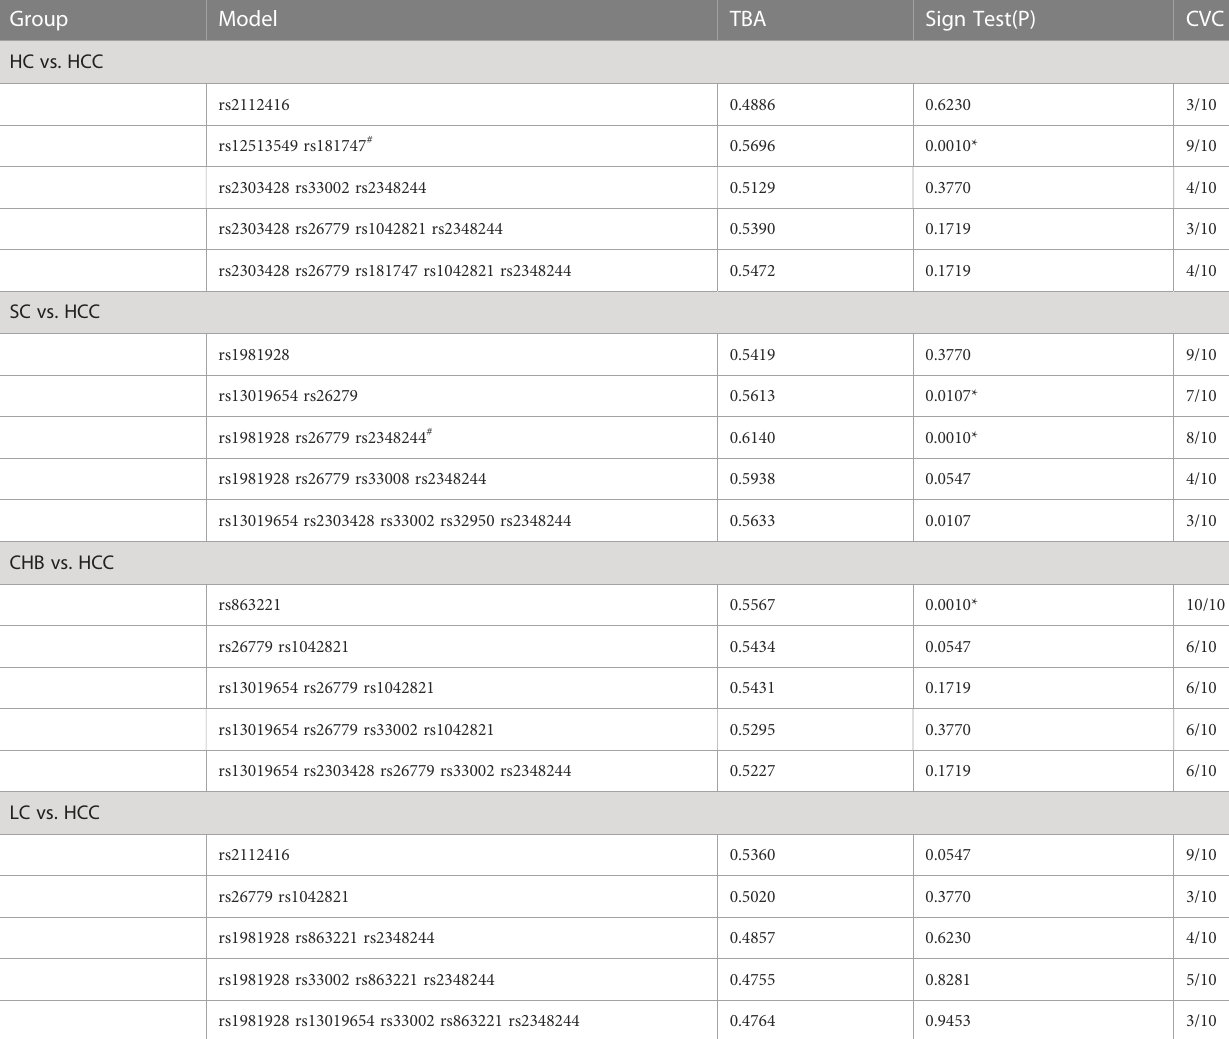
TABLE 3 GMDR analysis of 20 loci in HC vs. HCC, SC vs. HCC, CHB vs. HCC, and LC vs HCC groups.